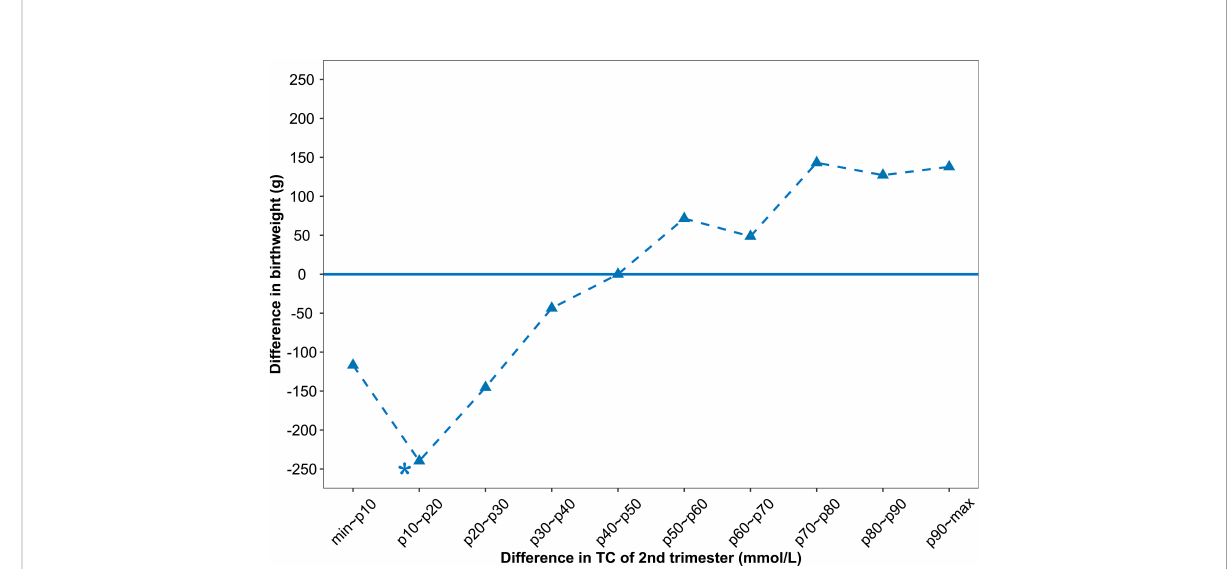
FIGURE 2 Associations between difference in 2 nd -trimester TC and difference in birthweight. The difference in birthweight is relative to the reference group (infants of mothers whose 2 nd -trimester TC increased by 40 th -50 th percentile (-0.20 ~ -0.03 mmol/L). The variable values refer to the values of the second observed pregnancy minus the value of the fi rst observed pregnancy for each